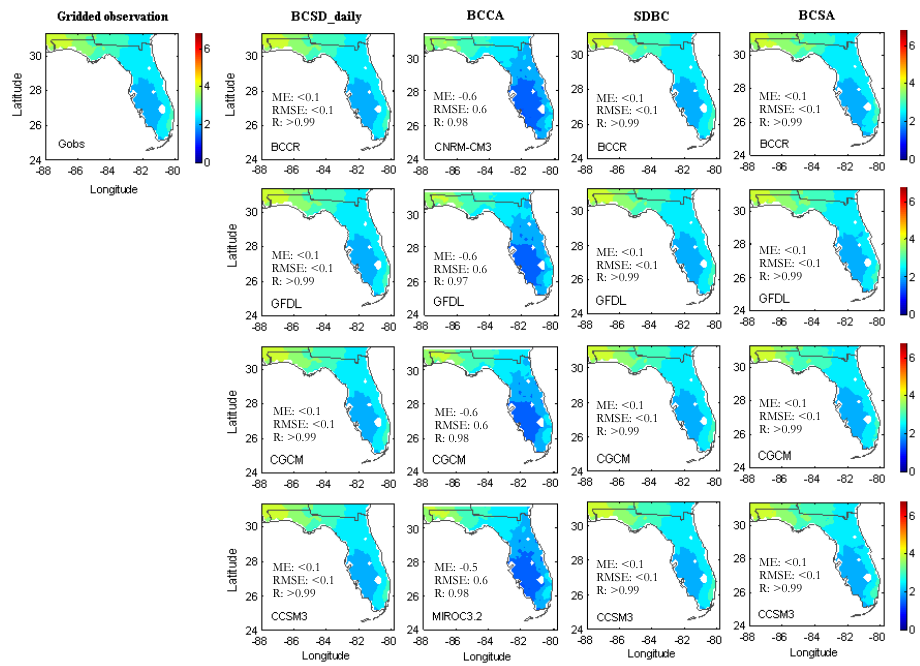
Fig. 5. Spatial distribution of the mean of gridded observation (Gobs), BCSD_daily, BCCA, SDBC, and BCSA daily precipitation for dry season (October through May), units in mm. ME, RMSE, and R are reported on each map for the bias-corrected